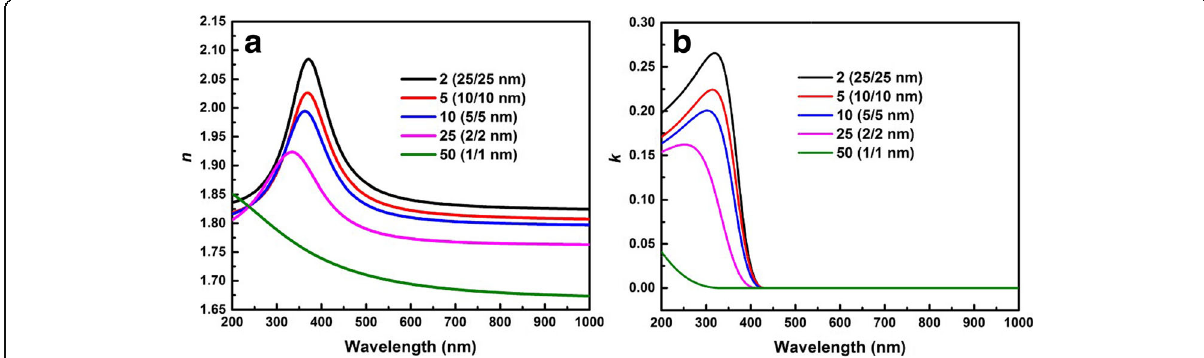
Fig. 6 The optical constants of nanolaminates grown on SiO 2 /Si substrate. a The refractive index n . b The extinction coefficient k